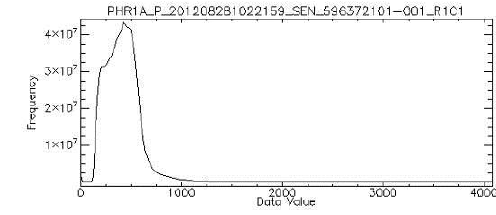
Fig. 3. Histogram of panchromatic band of image 1.